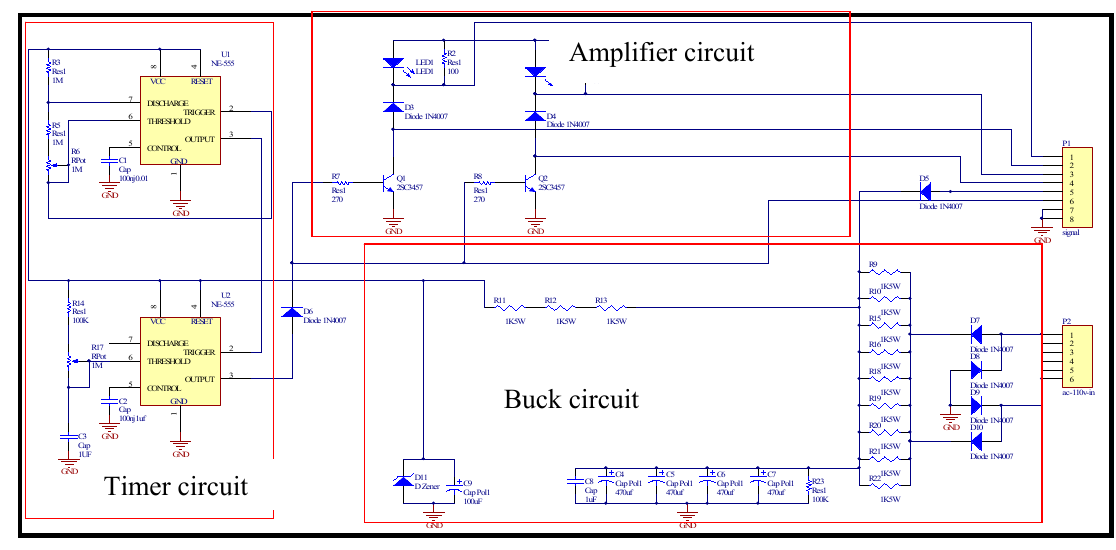
Figure 2. Overall circuit diagram.